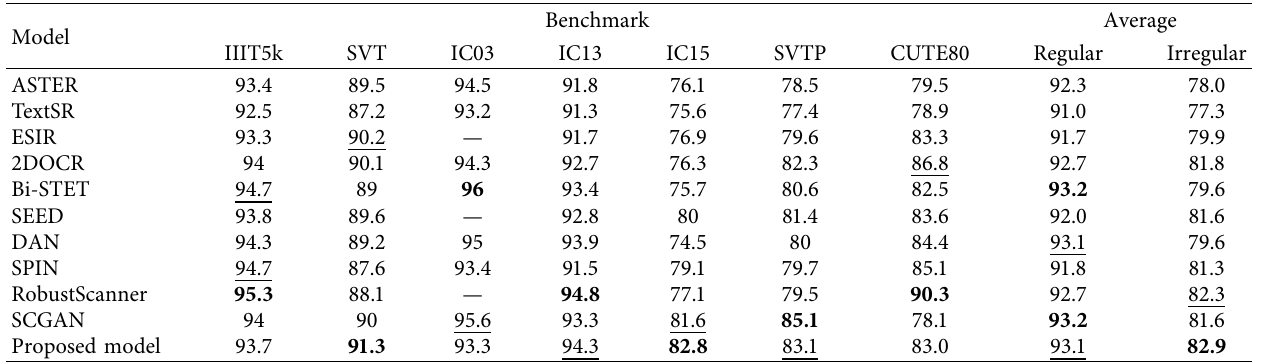
Table 1: The accuracy comparison between the proposed model and recent models (%).